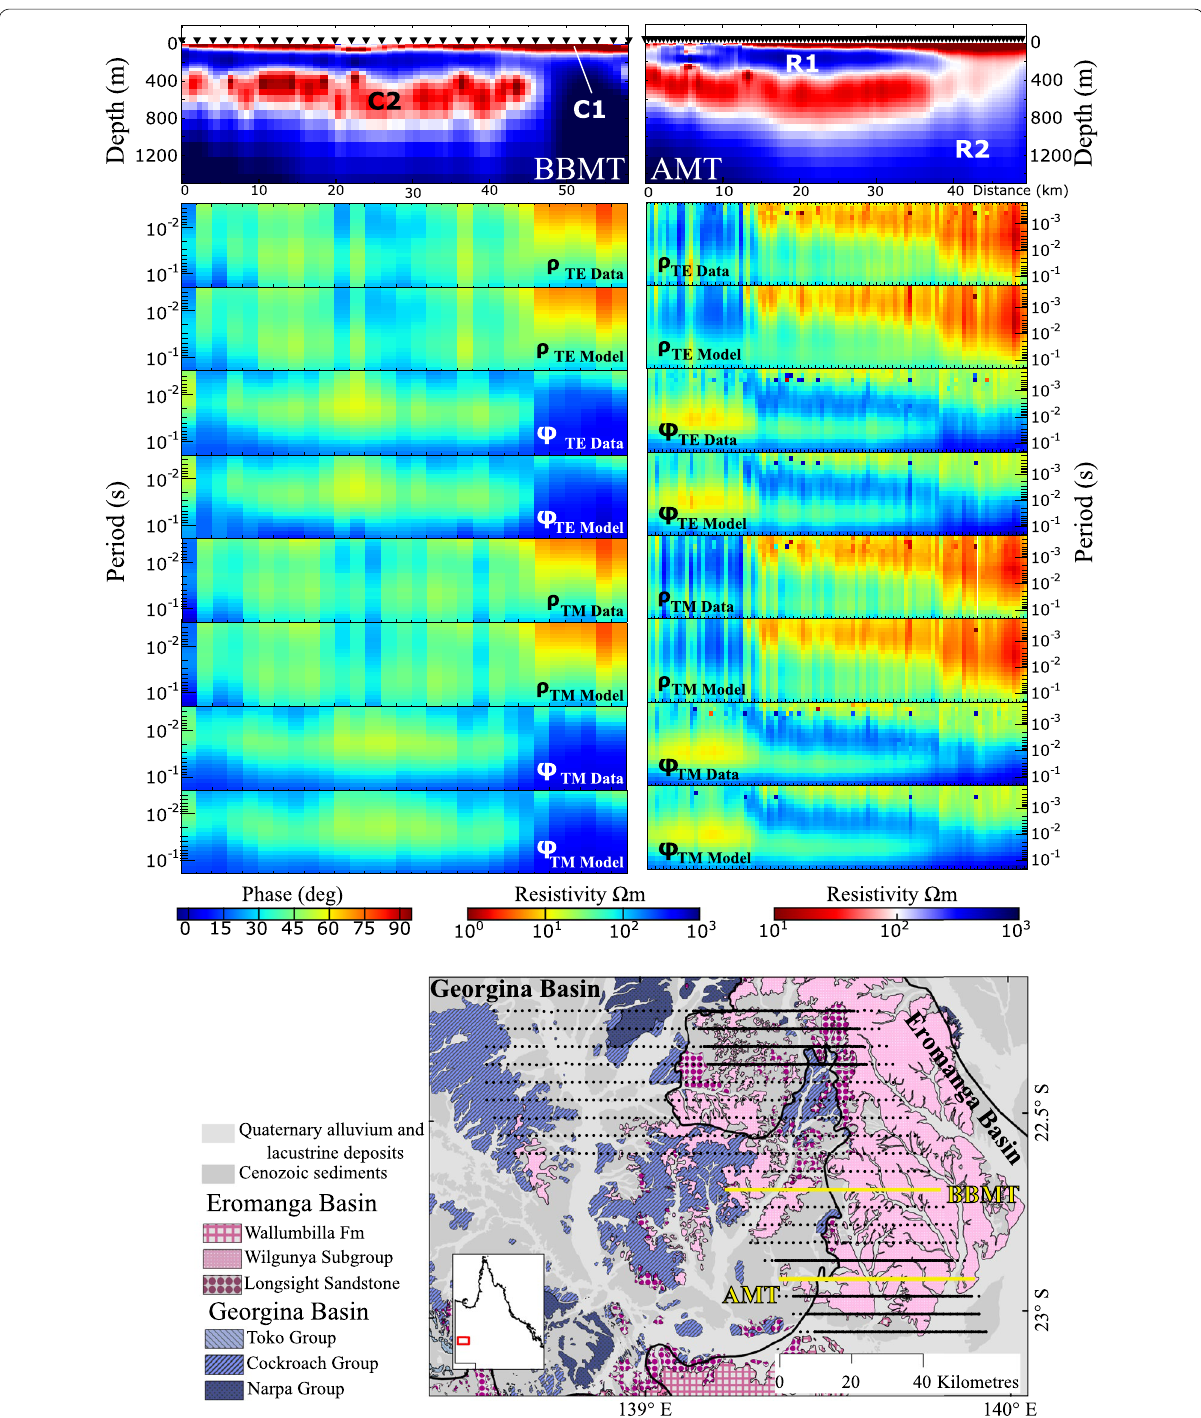
Fig. 7 Typical Occam 2D inversion results and data fit for BBMT (left) and AMT (right). Apparent resistivity ( ρ ) and phase ( φ ) pseudosections for the observed data compared to the calculated response (model) are displayed below the inversion section (top). Transverse electric (TE) and transverse magnetic (TM) modes both displayed. R1, R2, C1 and C2 features referred to in text are indicated. Location of two inversions indicated in yellow in bottom